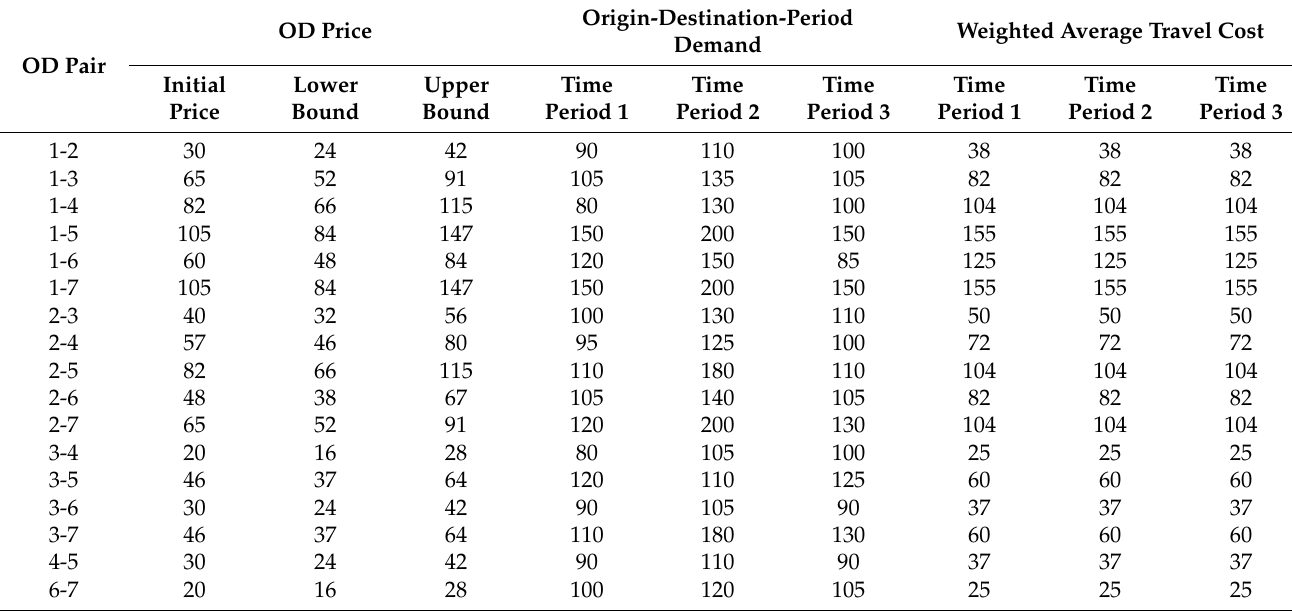
Table 4. The information of initial OD price and origin-destination-period demand.